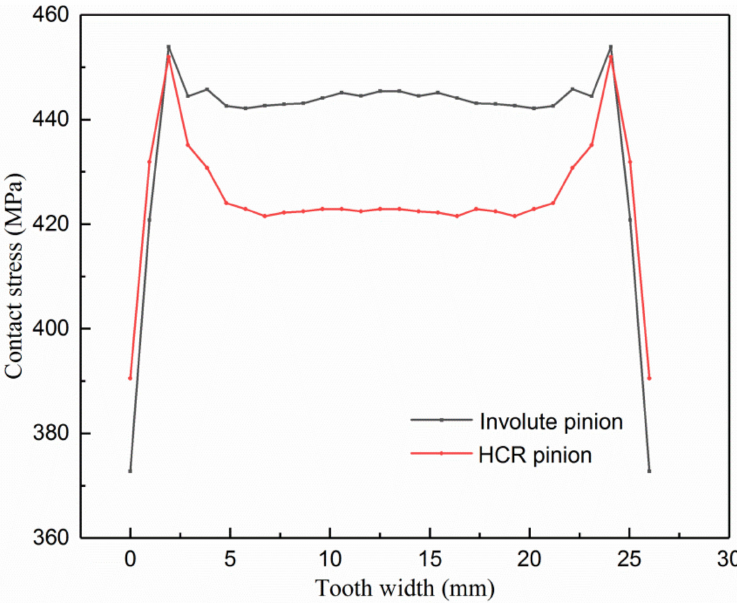
Figure 22. Contact stress curve of tooth surface in the direction of tooth